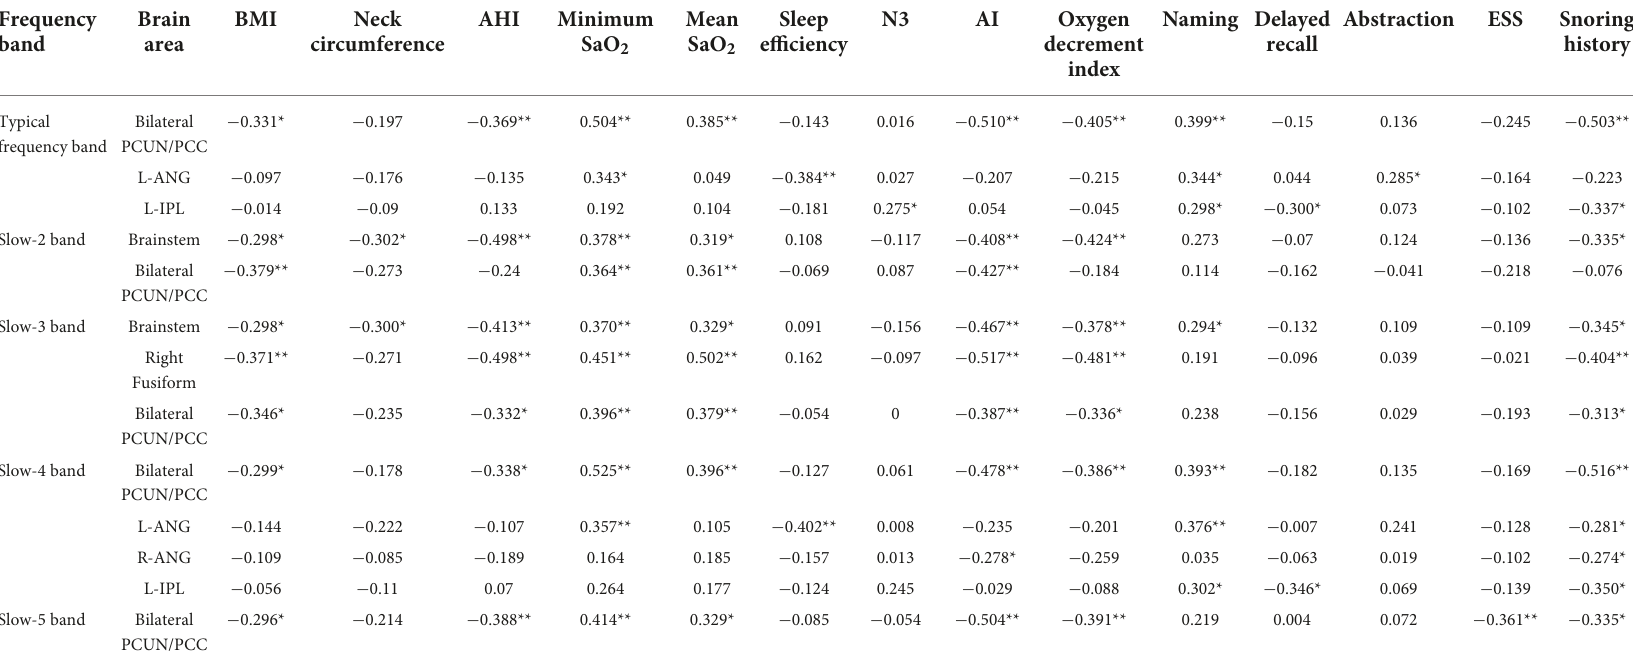
TABLE 5 Significant correlations between the altered ALFF in different bands and clinical assessment in OSA